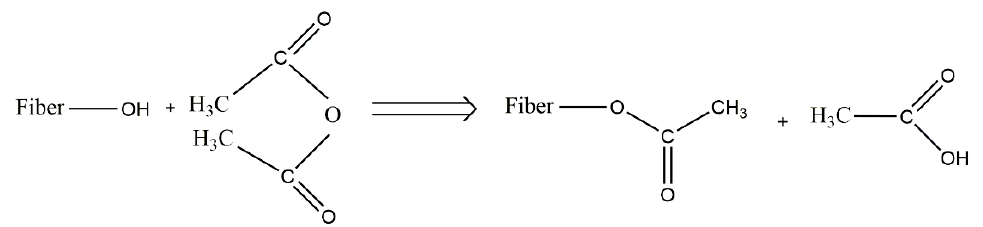
Figure 7. Reaction mechanism of a biofiber and maleic anhydride. Adapted from Elsevier [111]. Copyright Elsevier, 2012.